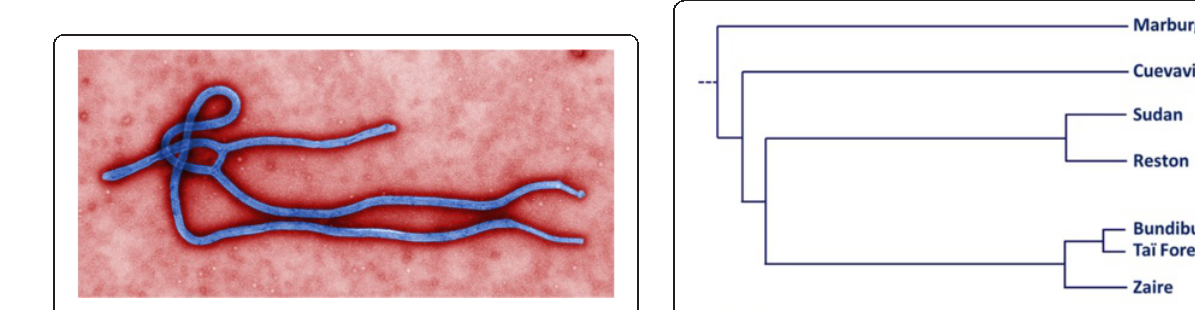
Figure 1 Ultrastructural morphology of Ebola virus virion (image by US Centers for Disease Control and Prevention and Cynthia Goldsmith).